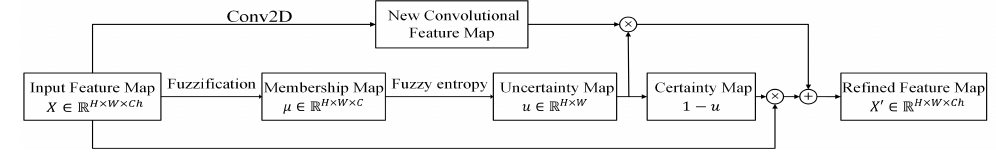
Figure 3. Spatial-wise fuzzy